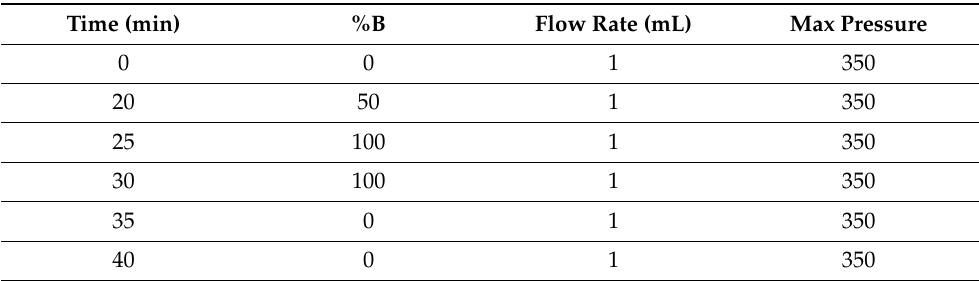
Table 1. Gradient volume of mobile phase B (%) added in the